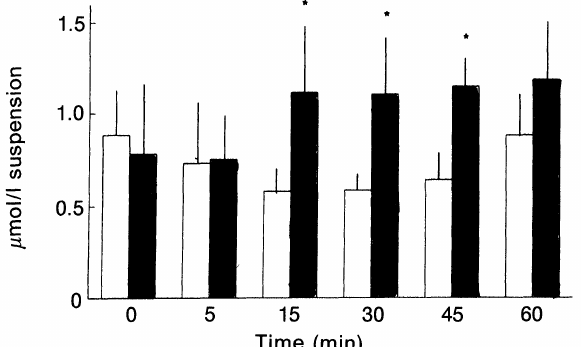
FIG. 2 Concentration of thiobarbituric acid--reactive substances in hepatocyte suspensions after bromotrichloromethane treatment. Symbols are" [] Control (addition of ethanol), [] bromotrichloromethane treatment (1 mM). Values are given as mean ___S.D. (*p<0.05 as compared with controls).